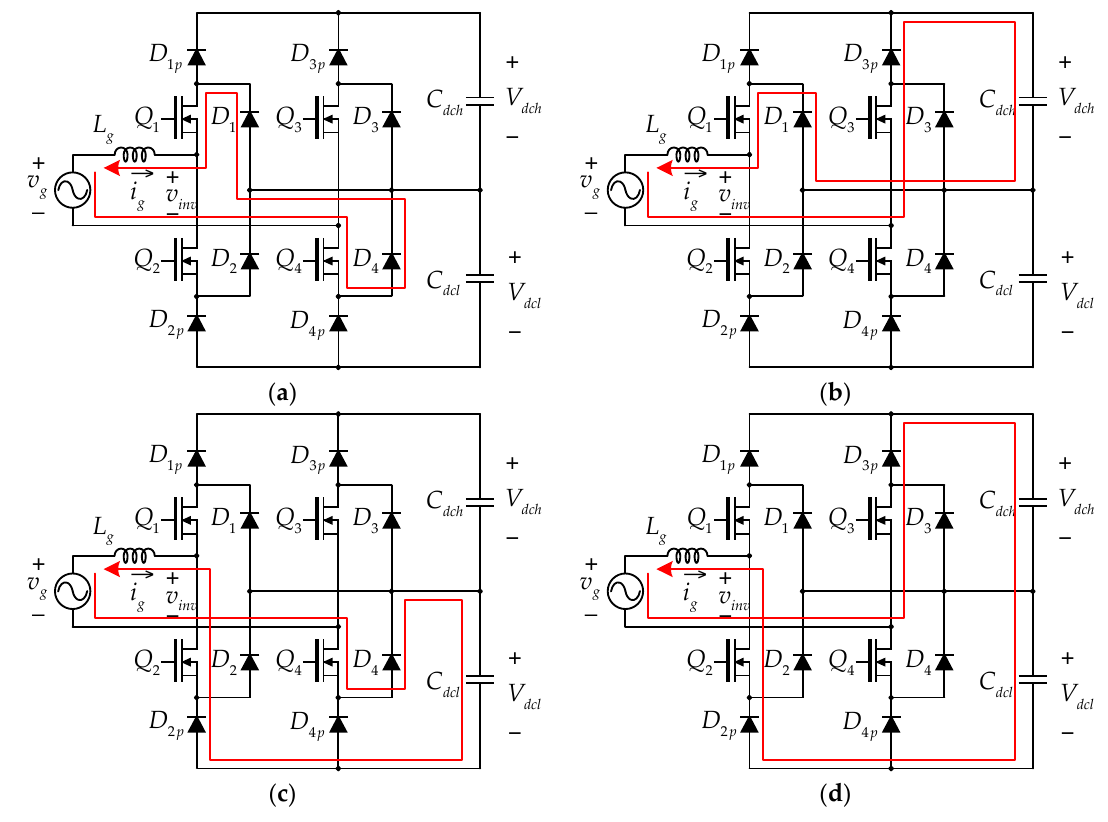
Figure 5. Operation modes of the three-level PFC converter under i g < 0. ( a ) Q = (1,1,1,1); ( b ) Q = (1,1,1,0); ( c ) Q = (0,1,1,1); ( d ) Q = (0,1,1,0). Table 2 summarizes the relationship between the switching functions and the pole voltages including all cases. If V dcl and V dch are well balanced, so that their magnitudes are the same as V dc , the PFC converter has five levels in total: − 2 V dc , − V dc , 0 V, V dc , and 2 V dc . It is well-known that carrier-based modulation strategies are simple, and much research has been conducted for the carrier-based pulse-width-modulation strategies in NPC applications [33–35]. Hence, a simple carrier-based method is employed in this